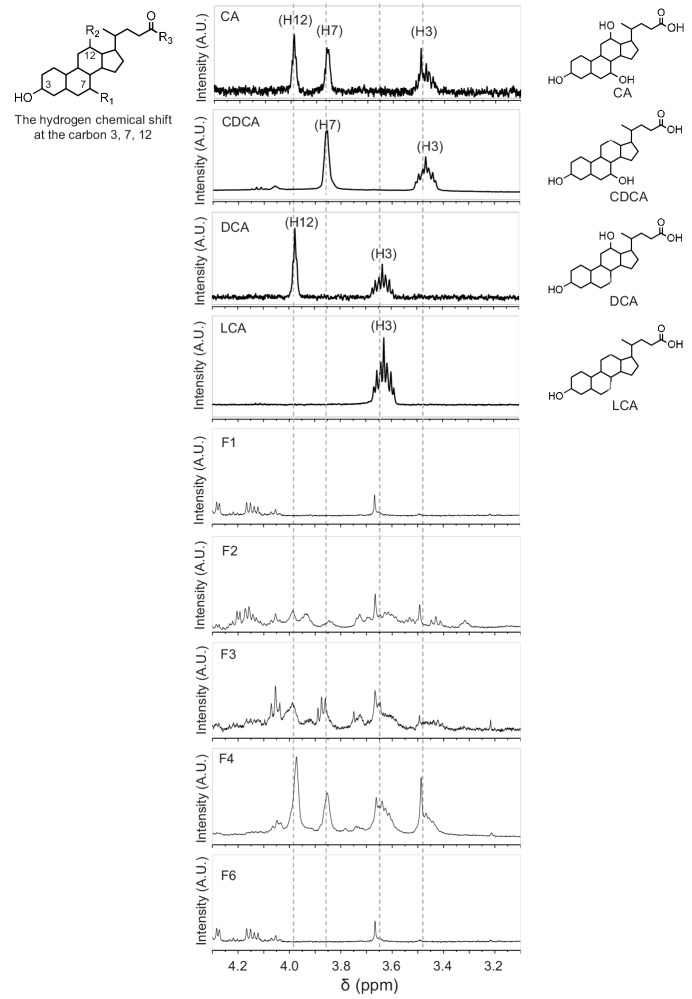
1H-NMR analysis of bile acids in fractions F1, F2, F3, F4, and F6.The hydrogen chemical shift of CA, CDCA, DCA, and LCA at carbon 3, 7, 12 were determined by 1H-NMR. Note that the active fractions (F2 through F4) contained the characteristic hydrogen peaks corresponding to these bile acids.